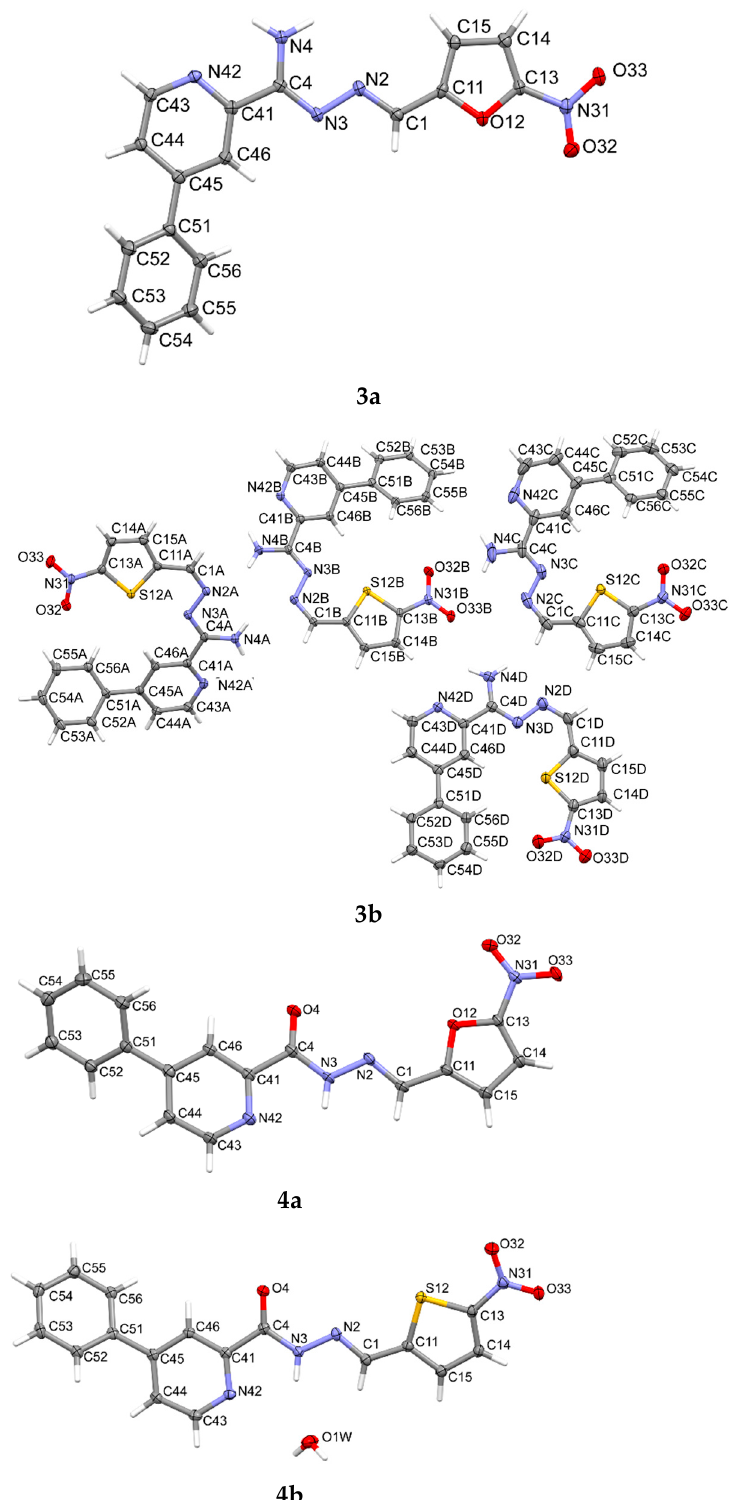
Figure 6. The molecular structures of compounds 3a , 3b , 4a and 4b , showing the atom-labeling schemes. Displacement ellipsoids are drawn at the 50% probability level, and H atoms are shown as small spheres of arbitrary radii. Drawings were prepared using the Mercury software. Table 3. Crystal data, data collection and refinement details.